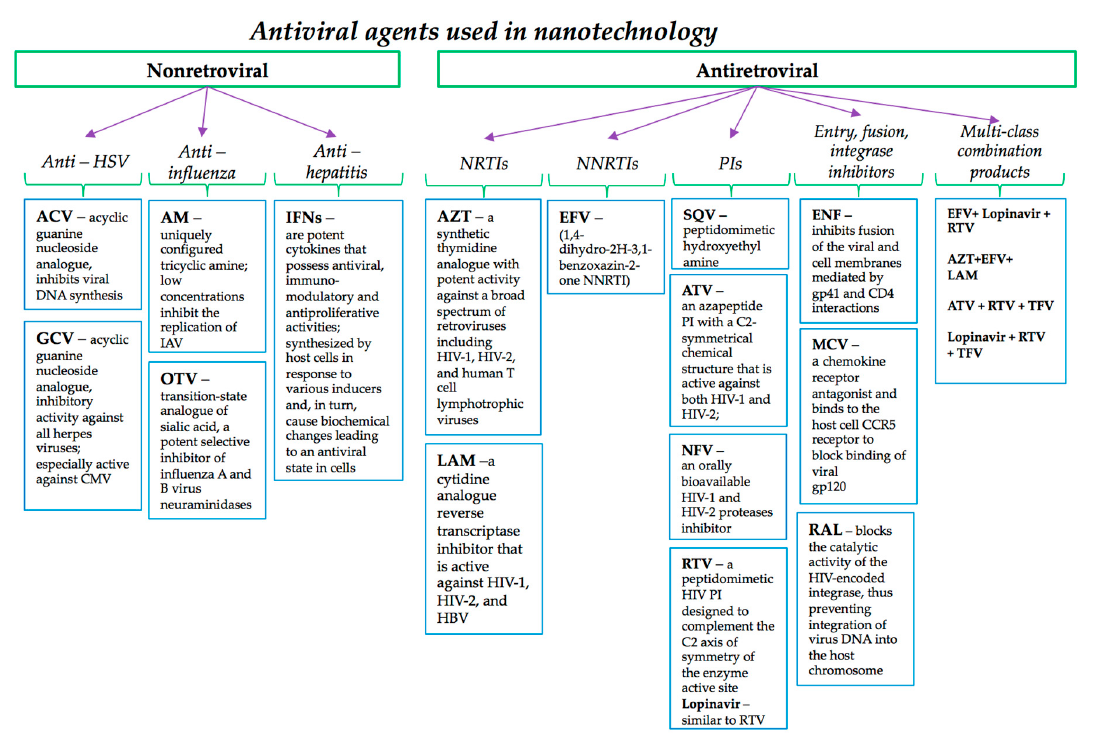
Figure 2. Summary of antiviral agents used in nanotechnology.